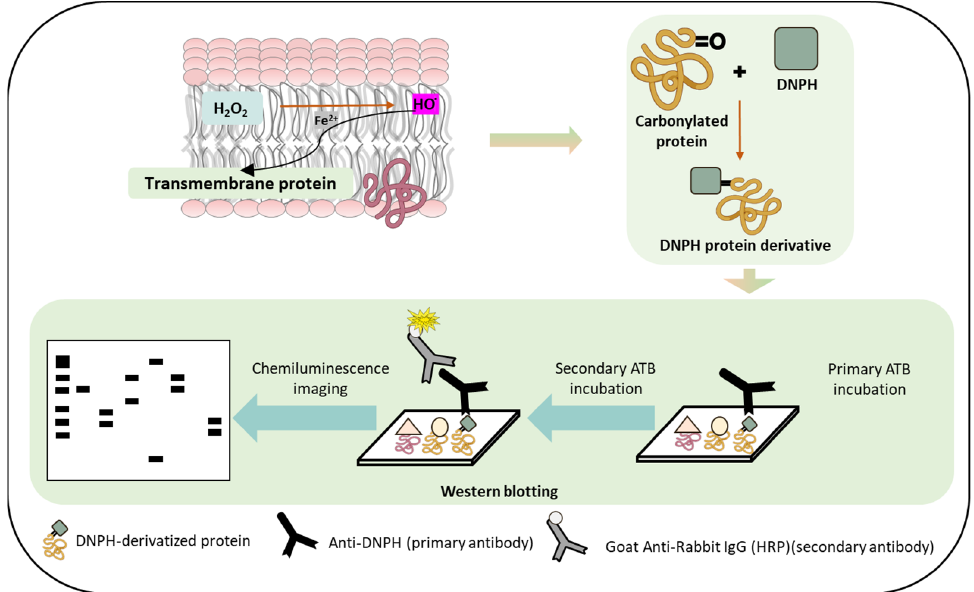
Figure 8. Schematic representation depicting the pathways of protein carbonyl formation which can occur as a result of protein oxidation. The lower panel depicts the use of immunoblotting techniques to detect protein carbonyl formation.